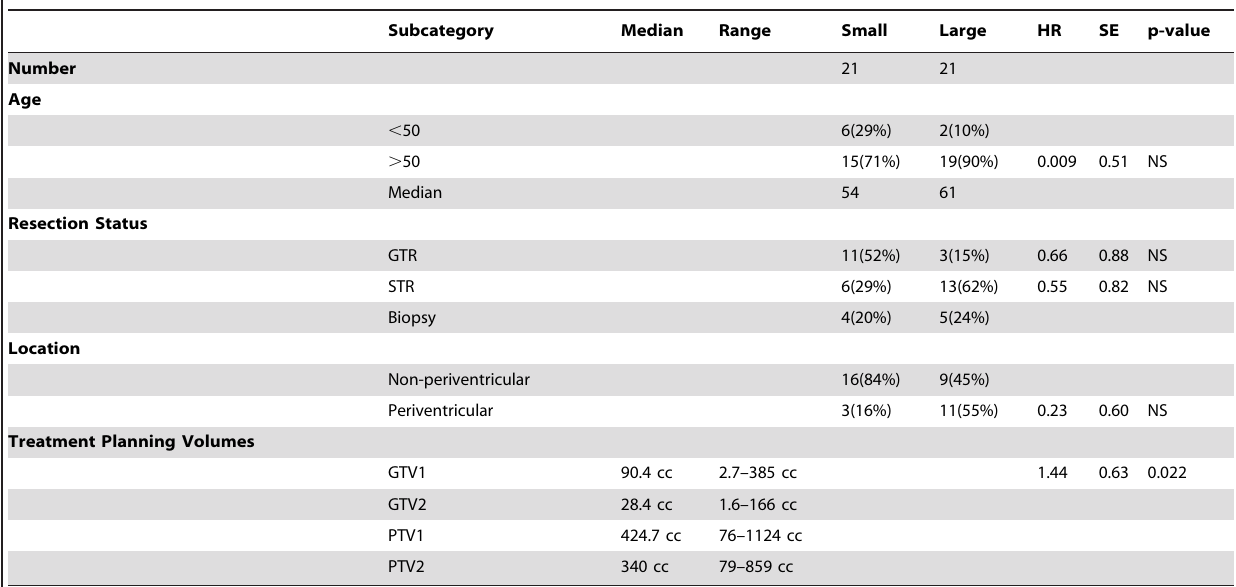
Table 2. Tumor Volume.